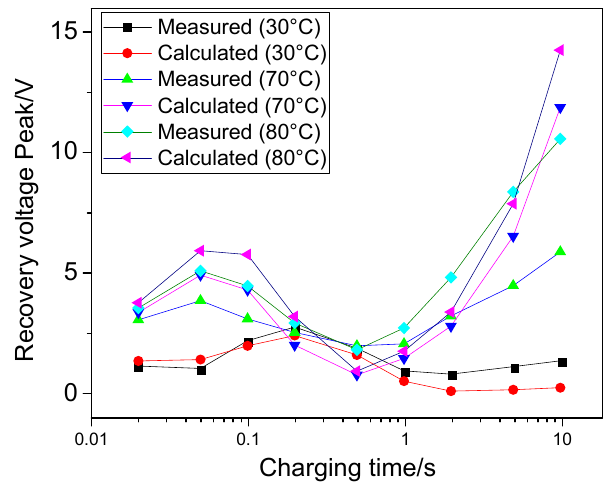
Figure 10. Measured vs. reconstructed RVM spectra modelled from the parameterized EDM using FDS